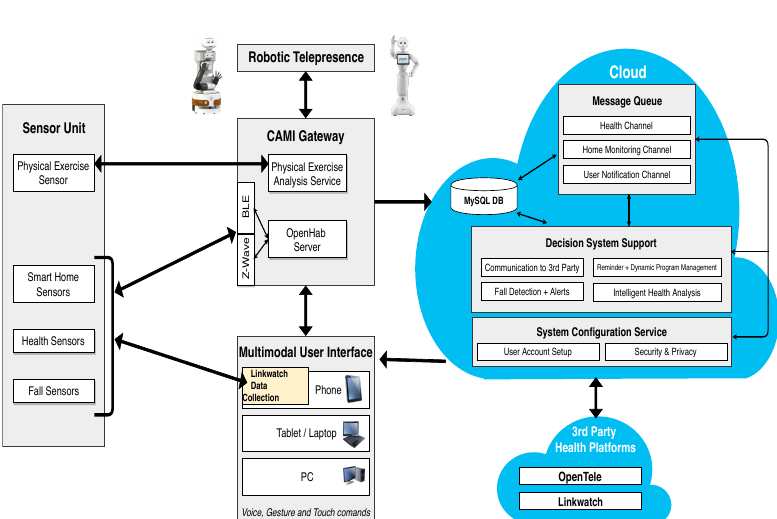
Figure 5. Category 1: A minimal configuration.